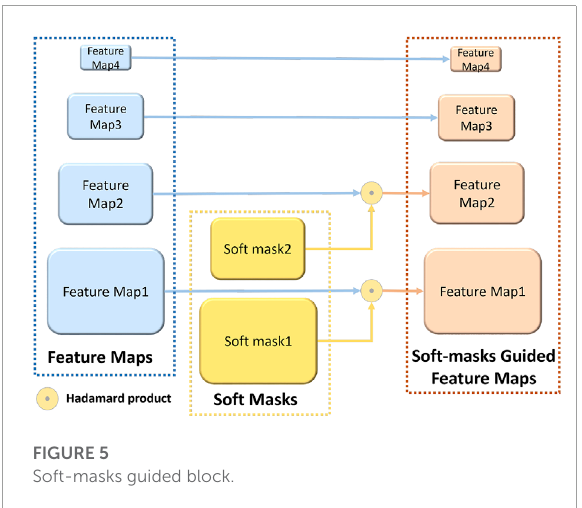
FIGURE 5 Soft-masks guided block.